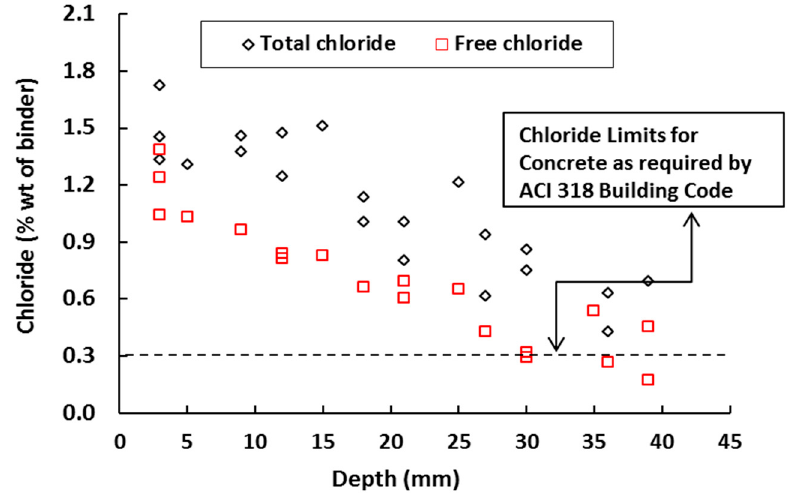
Figure 2. Chloride penetration at different depths in multiple cracked SHCC specimens (average crack width below 50 μ m) with 2% PVA fibers. Black diamonds and red squares refer to total and free chloride, respectively.